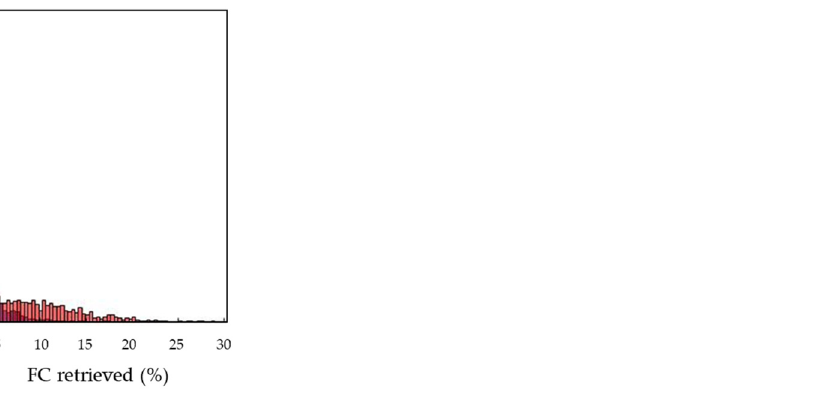
Figure 9. Histogram of the probability of occurrence (in %) of FC (in %) retrieved by the SRT inversion method (red) and by the δ MCI (blue) for the study area of the scene acquired on 8 July 2017.